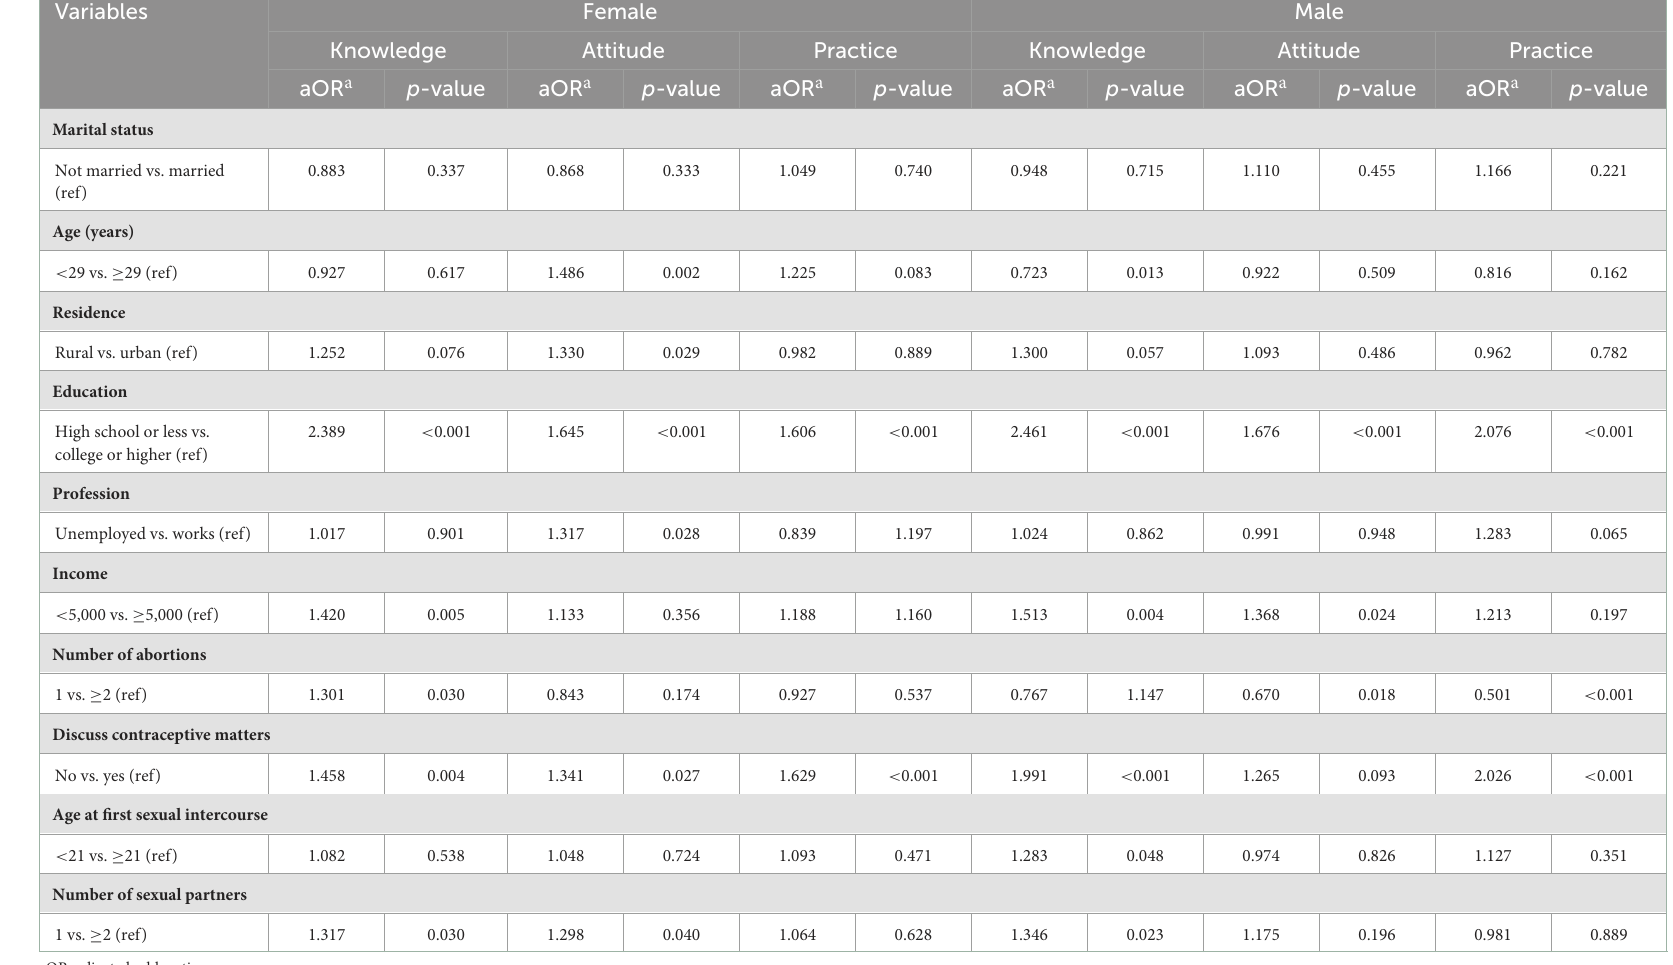
TABLE 3 Logistic regression for the associations between sociodemographic characteristics, reproductive health characteristics and KAP among Partners. Variables Knowledge Attitude Practice Knowledge